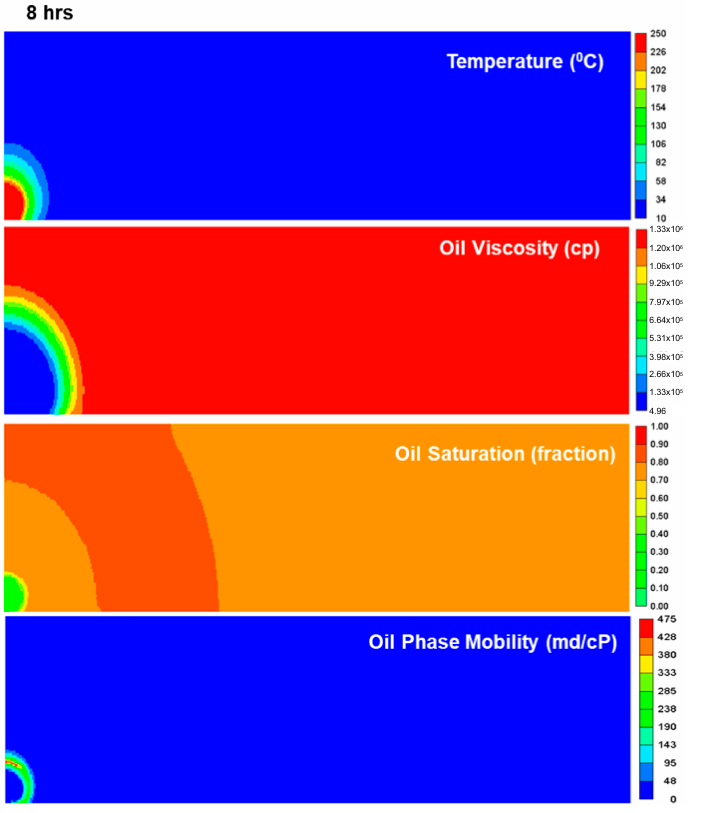
Figure 22. 2D images of the temperature, oil viscosity, oil saturation and oil phase mobility distributions of the HE model after 8 hours of steam injection. The height of the image has been exaggerated by two times.